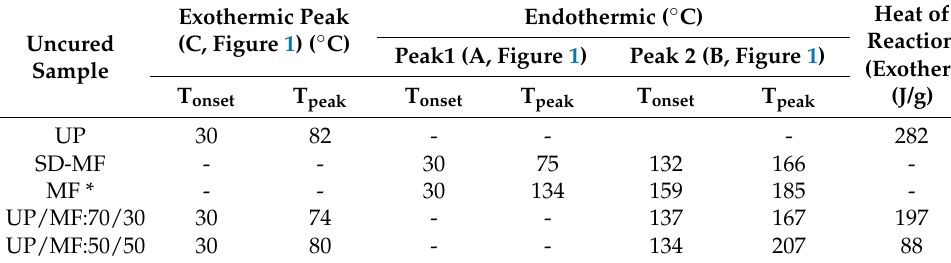
Table 2. DSC peak details and heat flow for uncured UP, UP/MF blends, and MF resin. Exothermic Peak (C, Figure 1) ( ◦ C) Uncured Sample